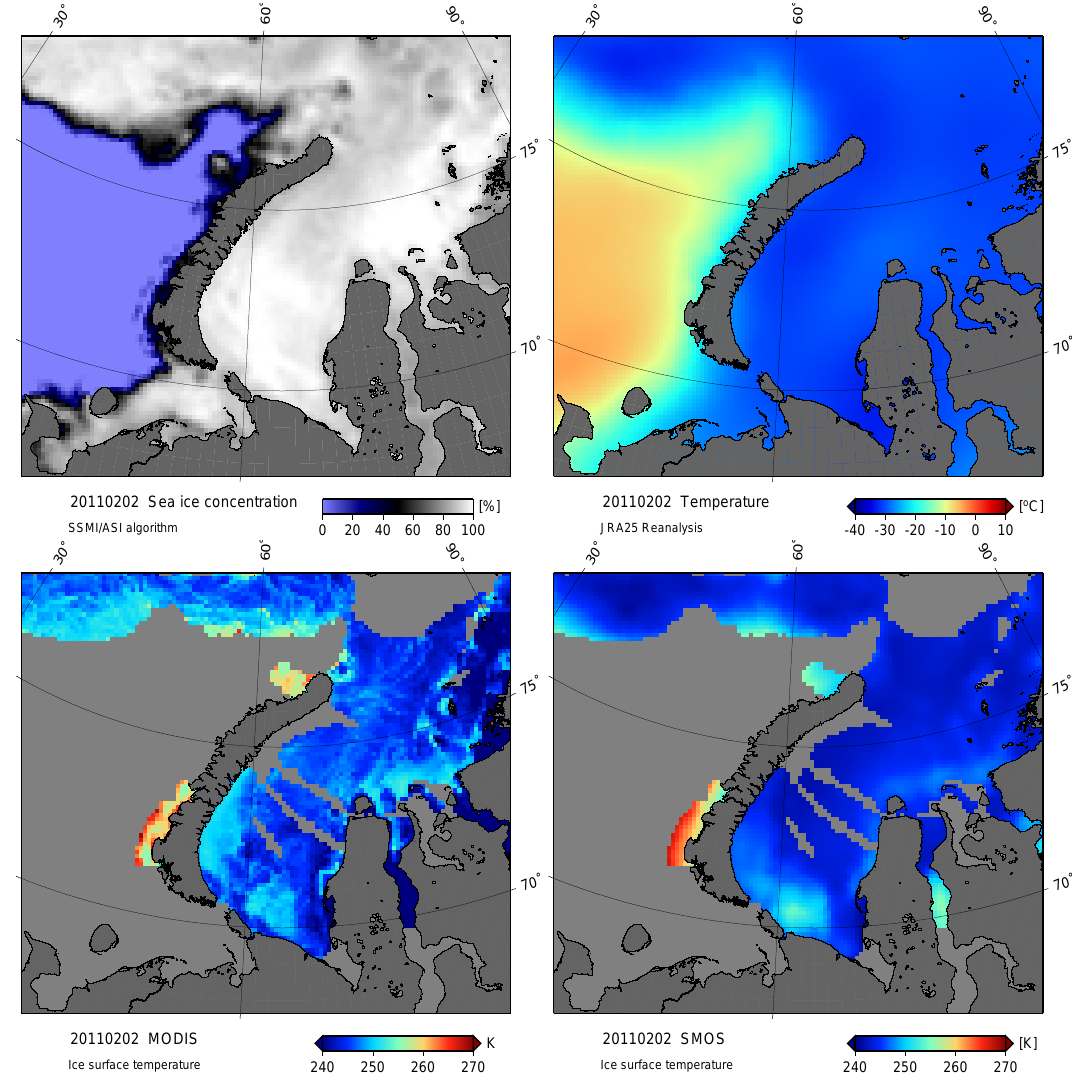
Figure 19. SSM/I ice concentration (upper left), JRA-25 surface air temperature (upper right), MODIS- and SMOS-based snow/ice surface temperature (lower left and lower right) in the Kara Sea on 2 February 2011. 58